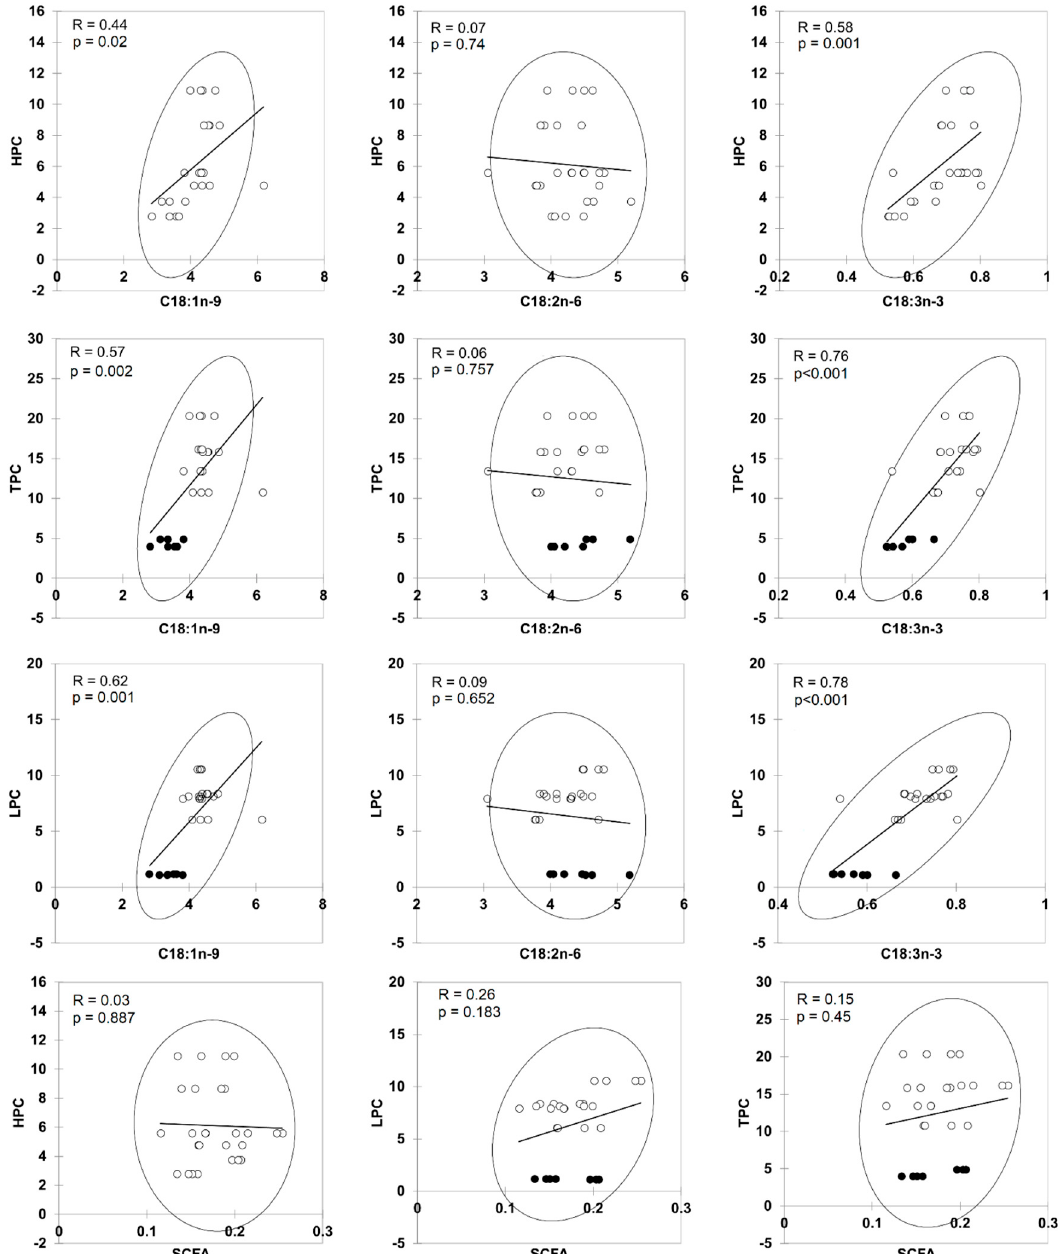
Figure 6. Scatter plots showing relationships between the phenolic content and unsaponified fatty acids in different commercial natural soaps after cold saponification. HPC = hydrophilic phenolic content, LPC = lipophilic phenolic content, TPC = total phenolic content. Short Chain Fatty acids (SCFA) = C8:0–C10:0.